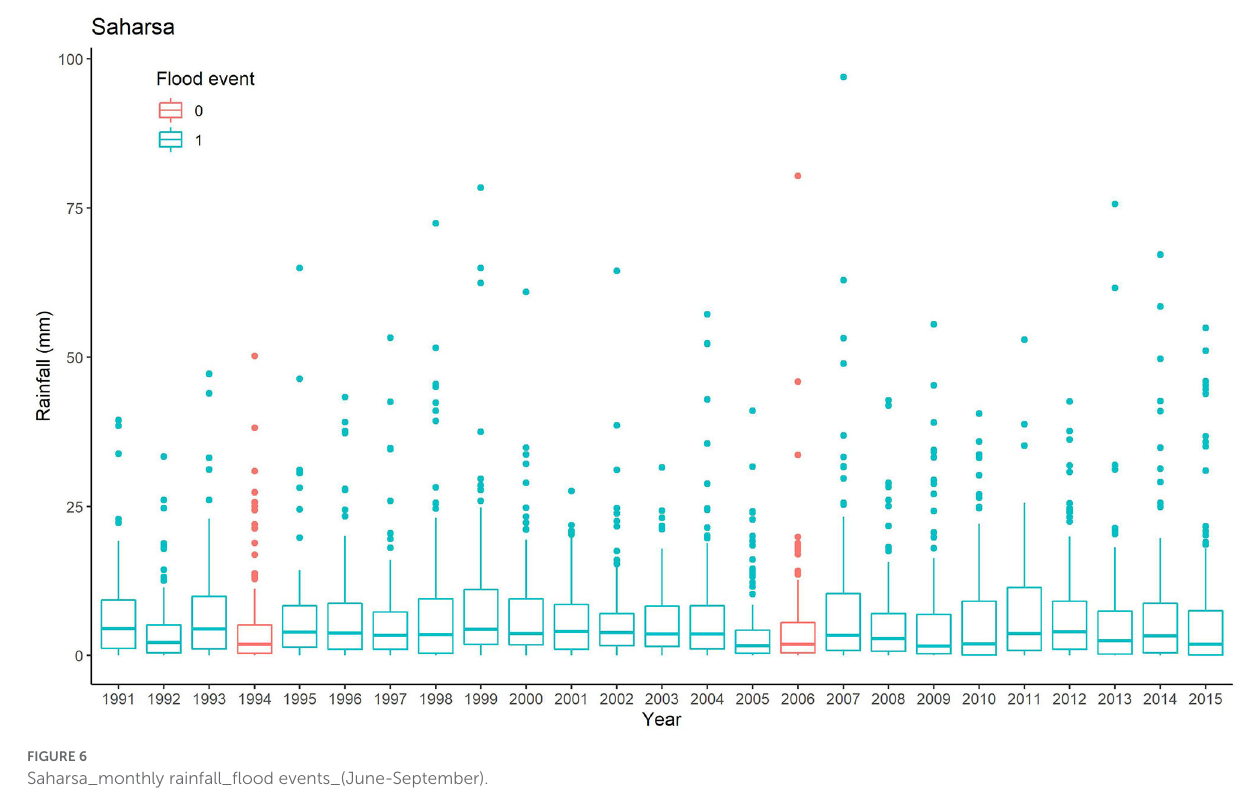
FIGURE6 Saharsa_monthly rainfall_flood events_(June-September).